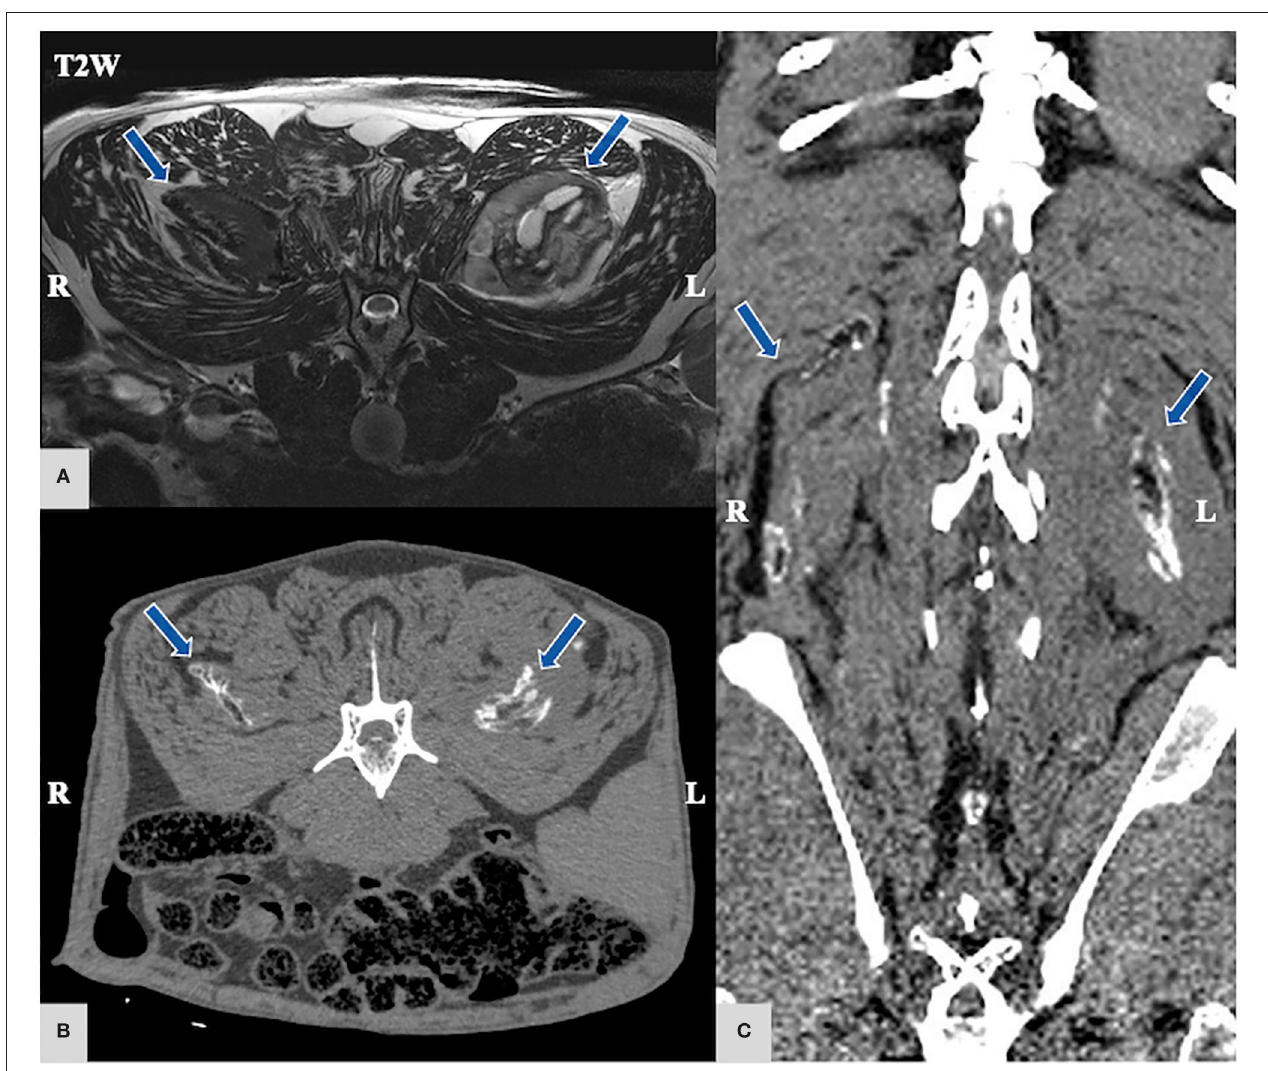
FIGURE 1 | (A) Magnetic Resonance Imaging (MRI) T2-weighted (w) transversal MRI sequence; (B,C) computed tomography (CT), CT transversal (B) and dorsal (C) region of the lumbar epaxial muscles arrows: bilateral mildly asymmetric, multilobulated, well-circumscribed mass lesions in the superficial erector spinae muscles that present hyper-, hypo-, and isointense areas in T2w in MRI without contrast enhancement. On CT scan, the preceding lesion presents a hypodense center surrounded by a hyperattenuating rim giving an “eggshell